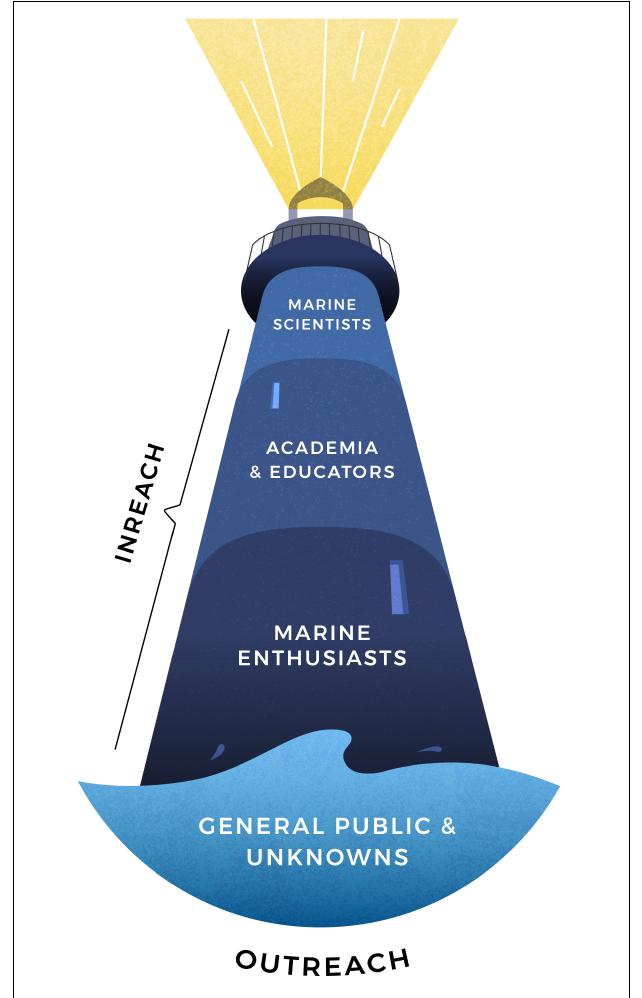
FIGURE 2 | User classification scheme. An artistic visualization of the INREACH–OUTREACH classification, emulating the tendency of marine science communication to circulate within a defined, like-minded network (represented by the